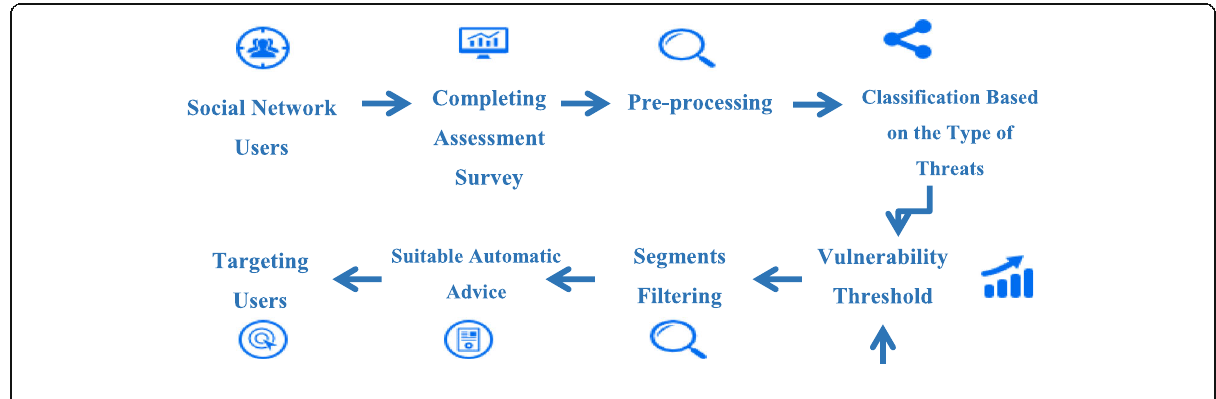
Fig. 2 A Semi-Automated Advisory